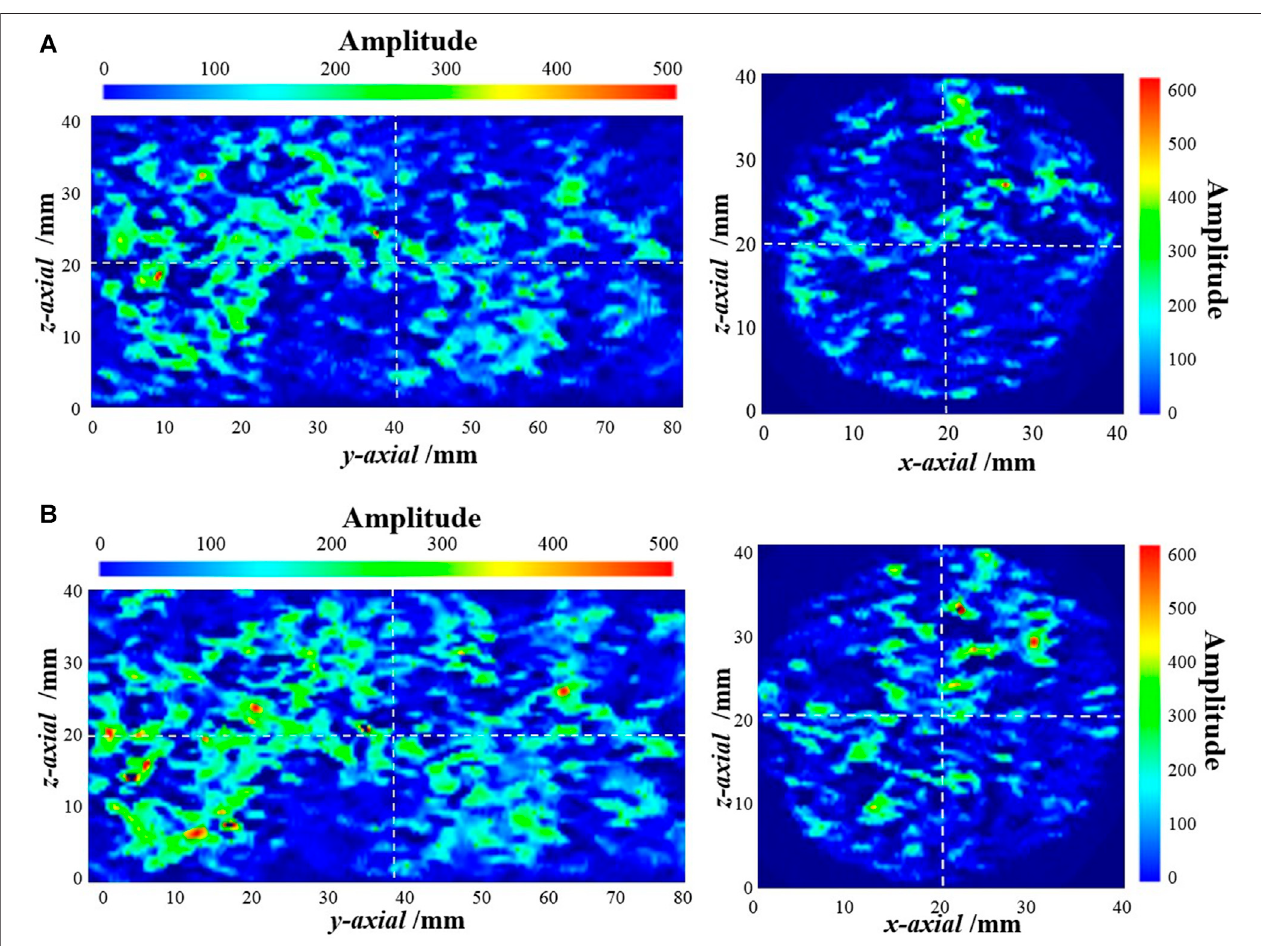
FIGURE 7 | T 2 -weighted images of GRS: (A) Original specimen, (B) F-T specimen.